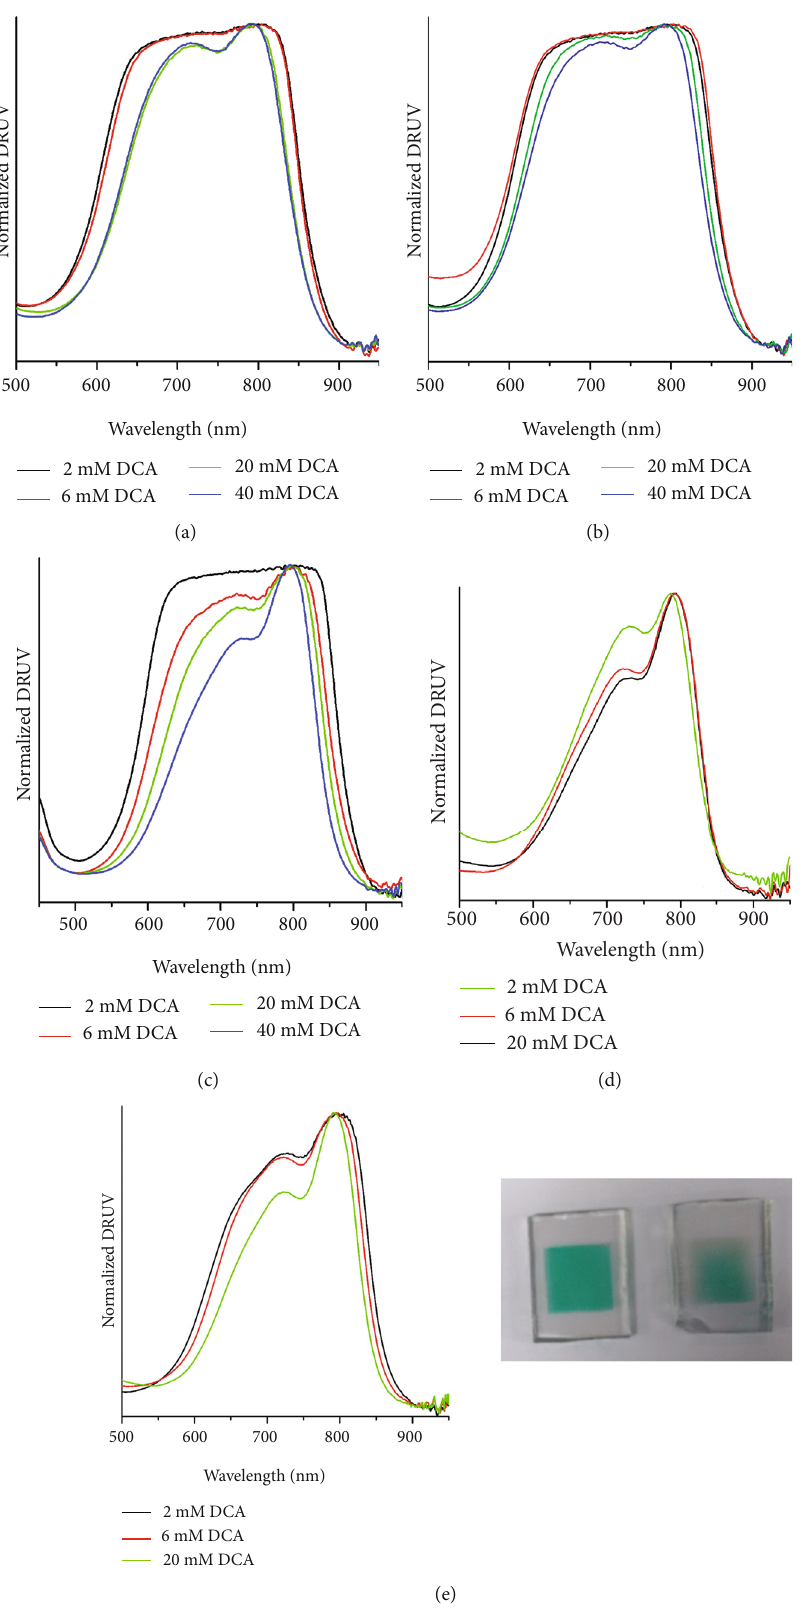
Figure 3: (a) Normalized UV-Vis spectra in the solid state of compounds 12-14 adsorbed on TiO fi lm adsorbed with compound 13. The inset presents the fl uorescence emission ( λ TiO 2